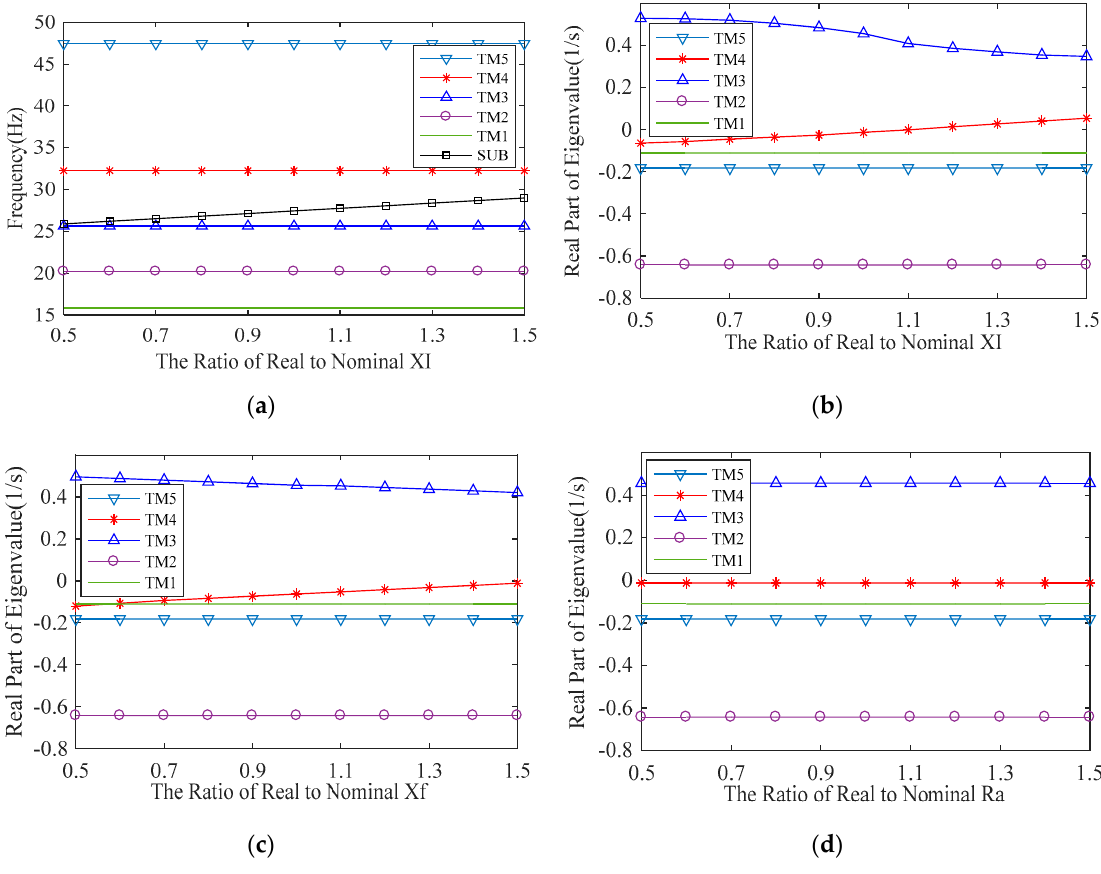
Figure 5. Influence of synchronous generator parameters on SSR characteristics. The imaginary parts of eigenvalues a ff ected by ( a ) X l , the real parts of eigenvalues a ff ected by ( b ) X l , ( c ) X f , ( d ) R a .